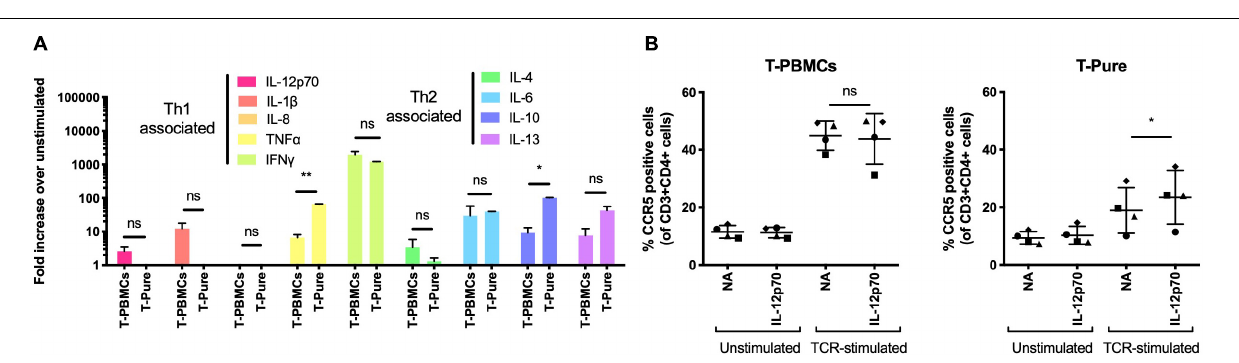
FIGURE 2 | Transfer of TCR-stimulated T-PBMC media increases the frequency of CCR5+ CD4+ T cells. (A) Schematic representation of experimental set-up. PBMCs were TCR-stimulated for 48 h, and then cell culture supernatant (ACT-PBMC-media) was collected for transfer to new cell cultures of T-PBMCs and T-Pure cells. T-PBMCs and T-pure cells were treated as described in Figure 1A except that ACT-PBMC-media was added at a 1:1 v/v ratio during the stimulation as indicated in the scheme. (B) Graph showing the frequencies of CCR5+ CD4+ T cells ( n = 5) under the experimental design described in panel (A) . (C) Flow cytometry plots showing T cell blasting by cells treated as described in panel (A) . Results are gated on live, singlet CD3+ CD4+ cells and are representative of data from one of five donors. Bars indicate mean values and each dot represent an individual donor. One-way ANOVA comparing untreated sample to every other sample. ** P < 0.01; *** P < 0.001.